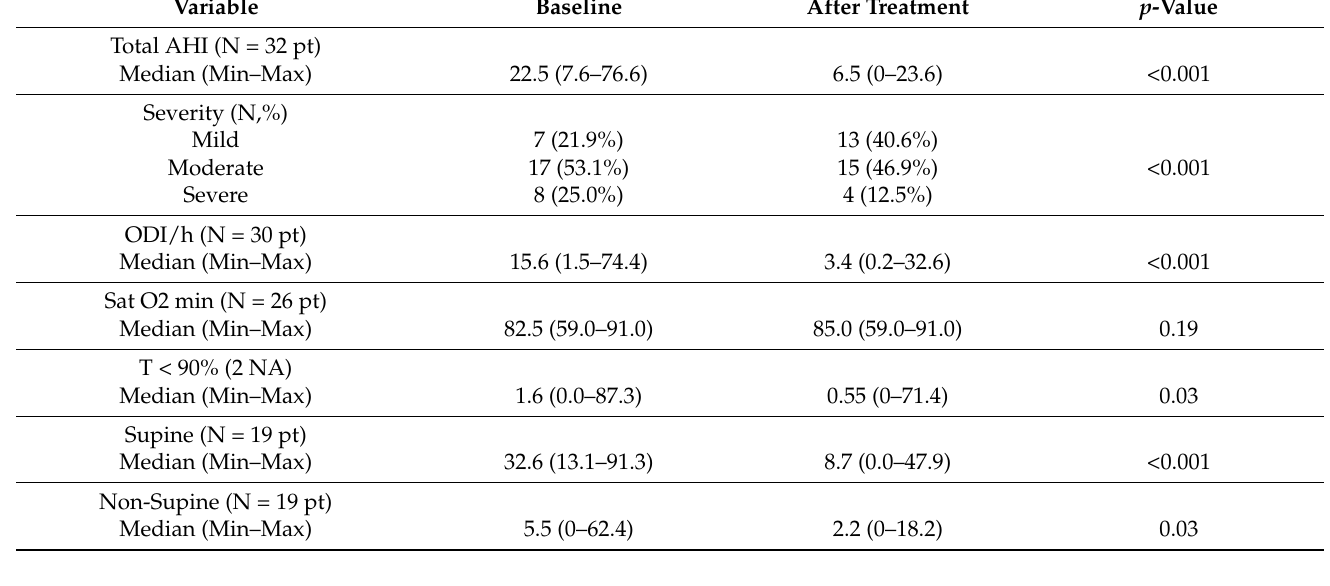
Table 4. Polygraphic variable before and after treatment.